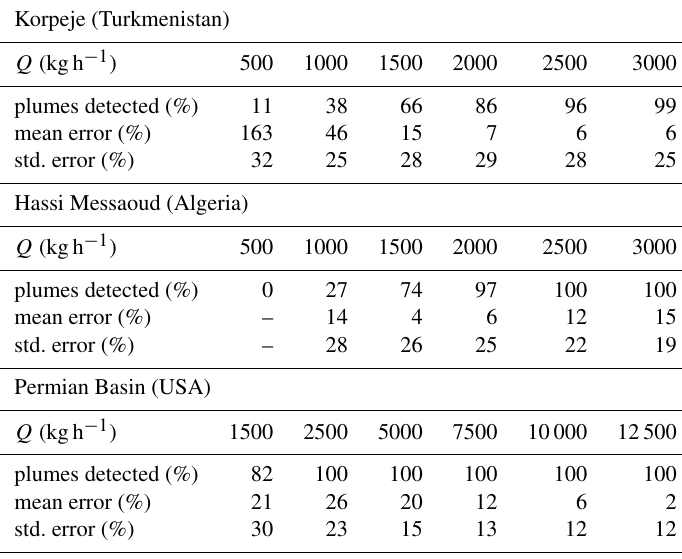
Table 3. Methane flux rate detection limit for the selected sites at Korpeje (Turkmenistan) (see Fig. 2a), Hassi Messaoud (Algeria) (see Fig. 2b) and the Permian Basin (USA) (see Fig. 2c) under the two different detection masking criteria (conservative and supervised) detailed in Sect.